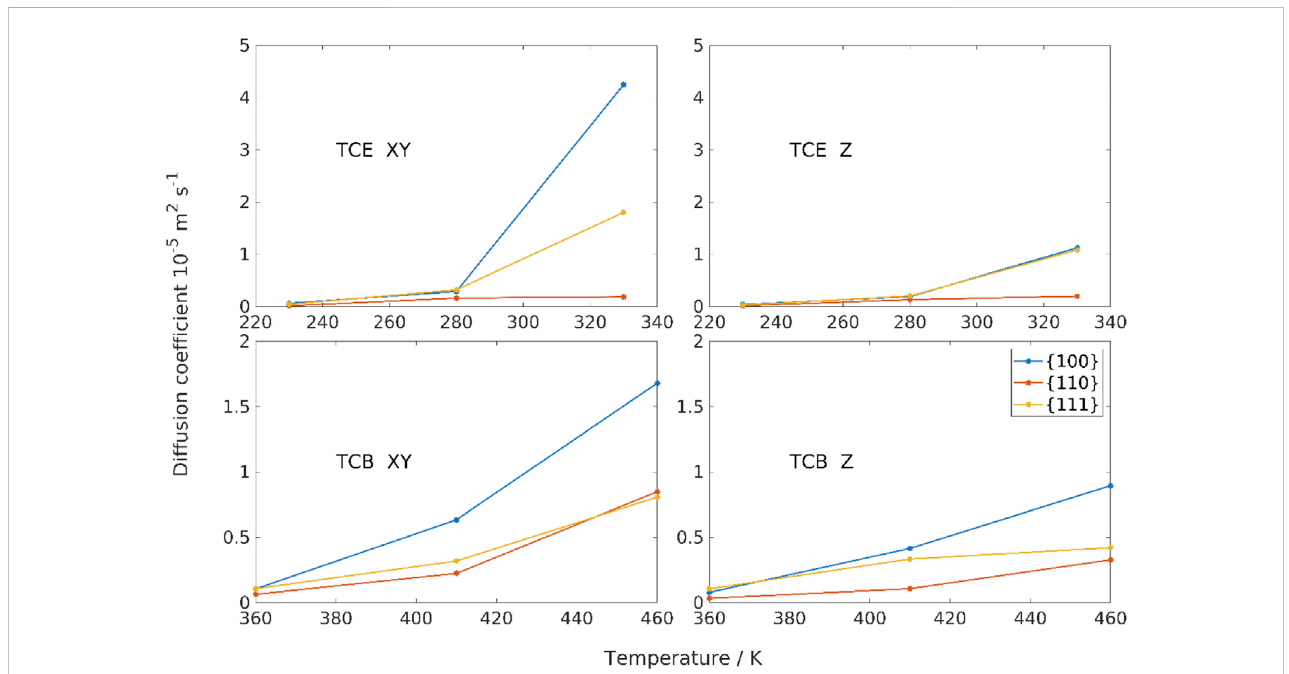
FIGURE 8 Directional diffusion coef fi cients in the adsorption region for TCB and TCE on three Pd facets as a function of temperature. XY refers to the planar diffusion parallel to Pd substrate. Z refers to the diffusion perpendicular to the Pd substrate.